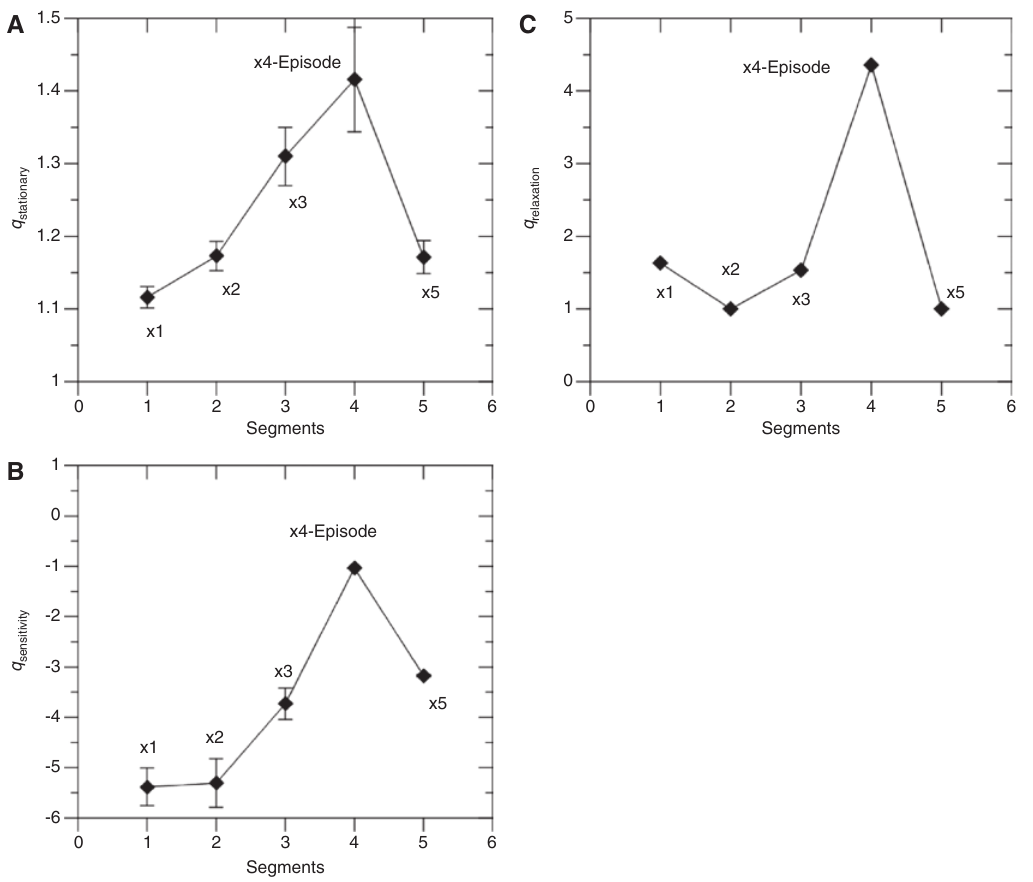
Figure 3: Tsallis indices. (A) Tsallis q index estimated for the five segments of Figure 1A. (B) Tsallis q stat q index estimated for the five segments of Figure rel